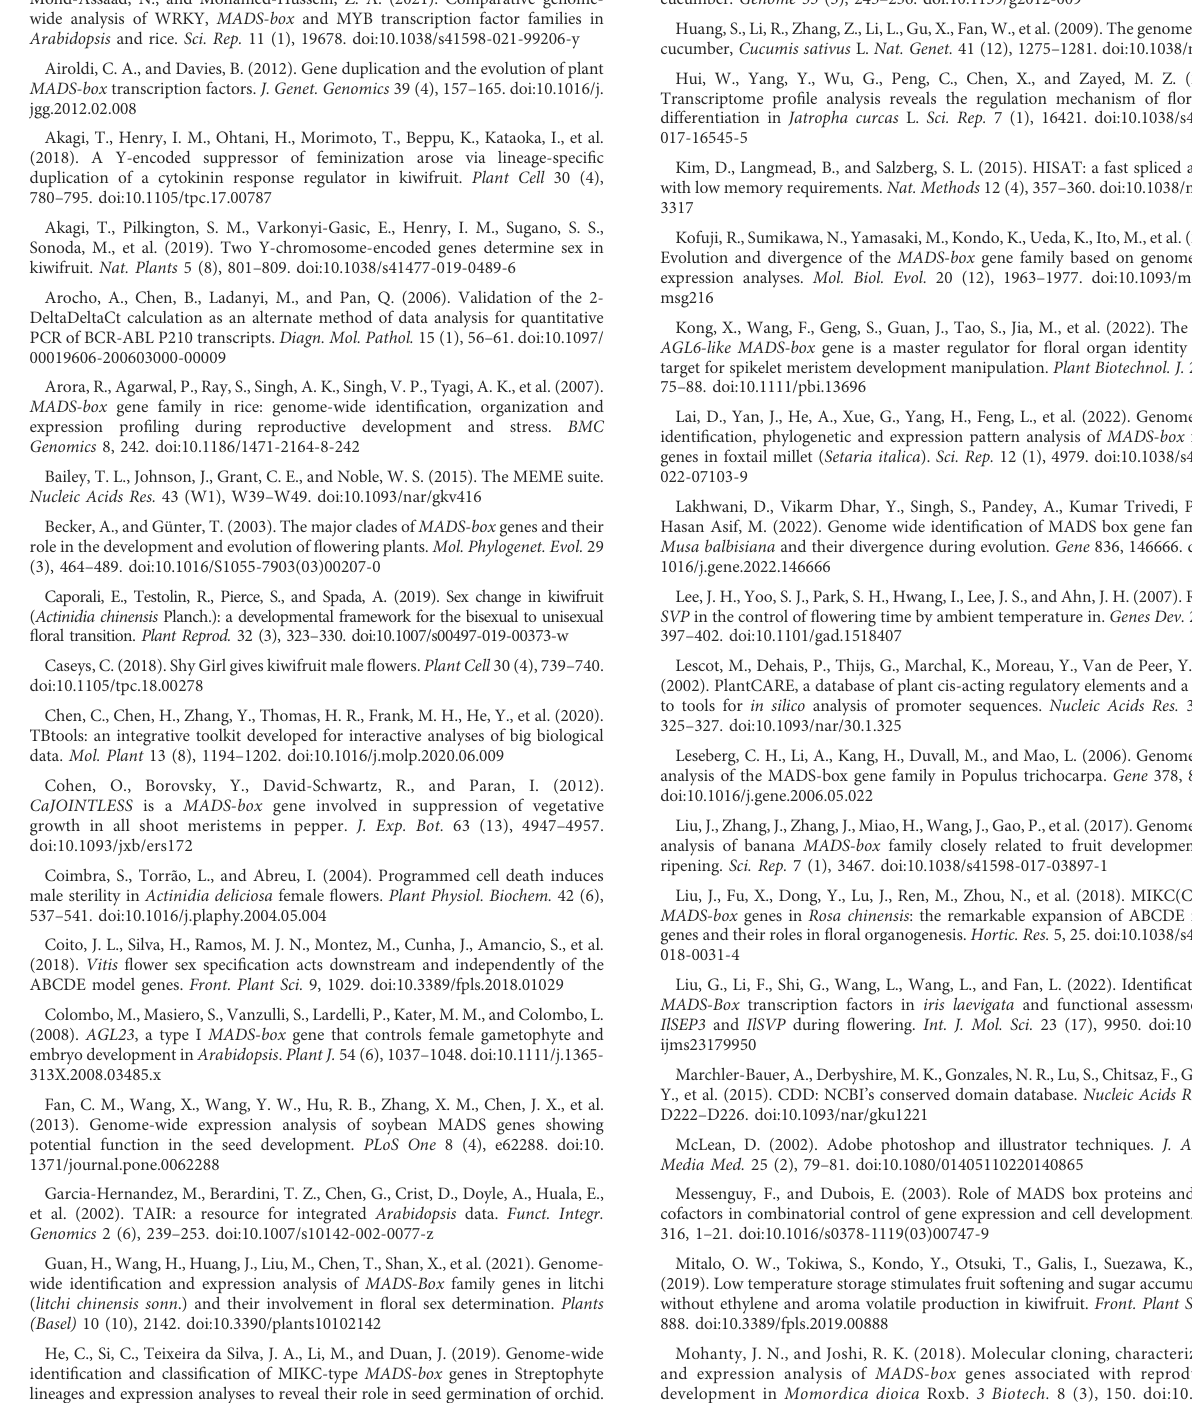
SUPPLEMENTARY FIGURE S1 Number of A. chinensis MADS-box genes on each chromosome.